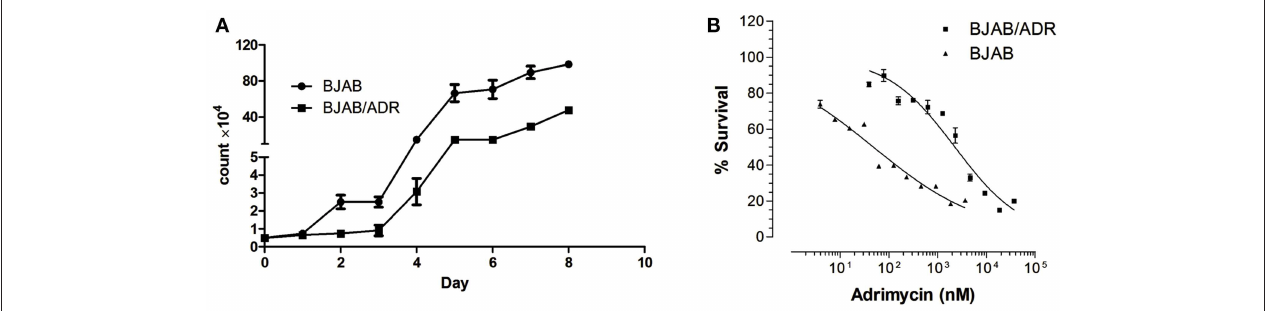
FIGURE 2 | Cell growth curve of BJAB and BJAB/ADR cells. (A) Growth curves of BJAB and BJAB/ADR cells. BJAB/ADR cells grew slower than BJAB cells ( P < 0.05). (B) Cytotoxicity of adriamycin against BJAB and BJAB/ADR cells. Each data point was obtained from three independent experiments in triplicate. BJAB/ADR cells were resistant to adriamycin.